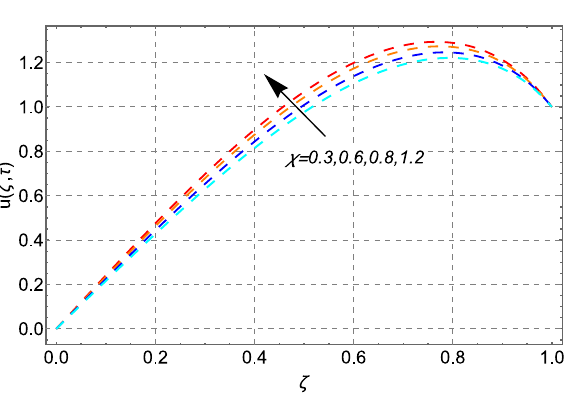
Figure 4. Impact of Casson fluid parameter χ on velocity